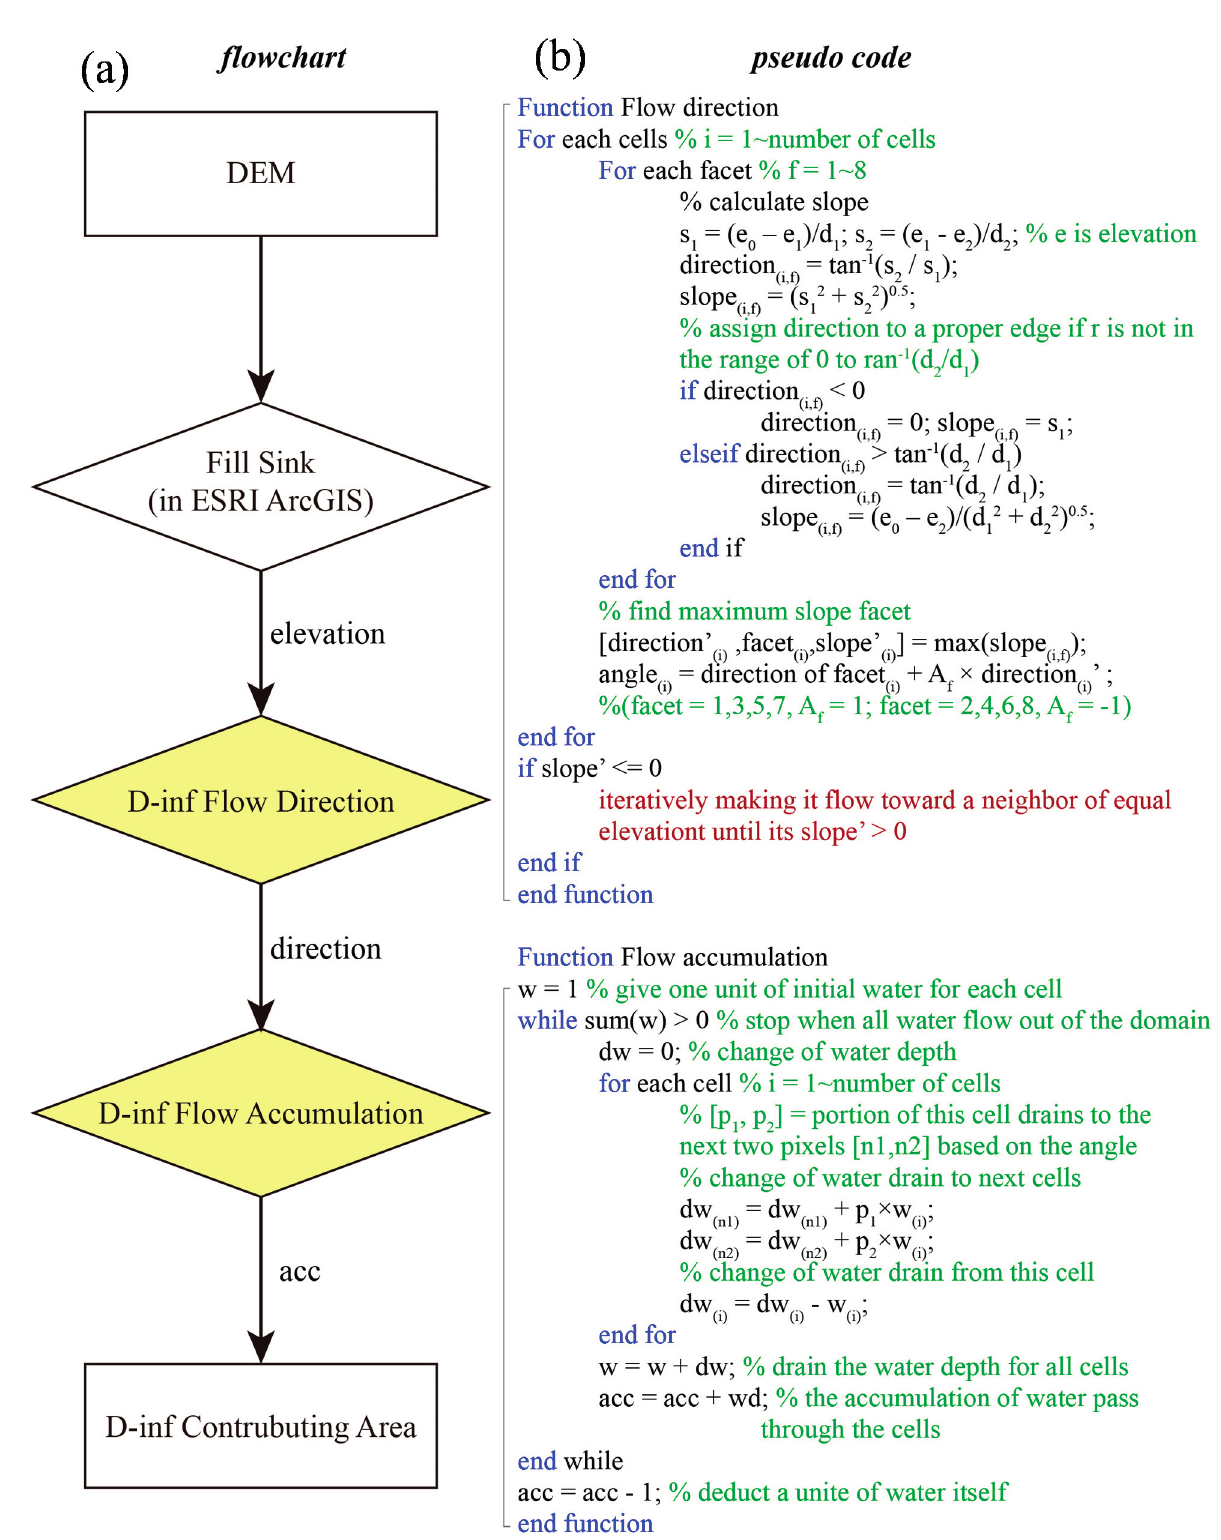
Figure 2. Flowchart and pseudo code for D-infinity contributing area: ( a ) The chart shows the pseudo codes of D-inf flow direction and D-inf flow accumulation (yellow rhombus in the flowchart); ( b ) The blue code is for loop or if statement; green is comment; red is an iteratively